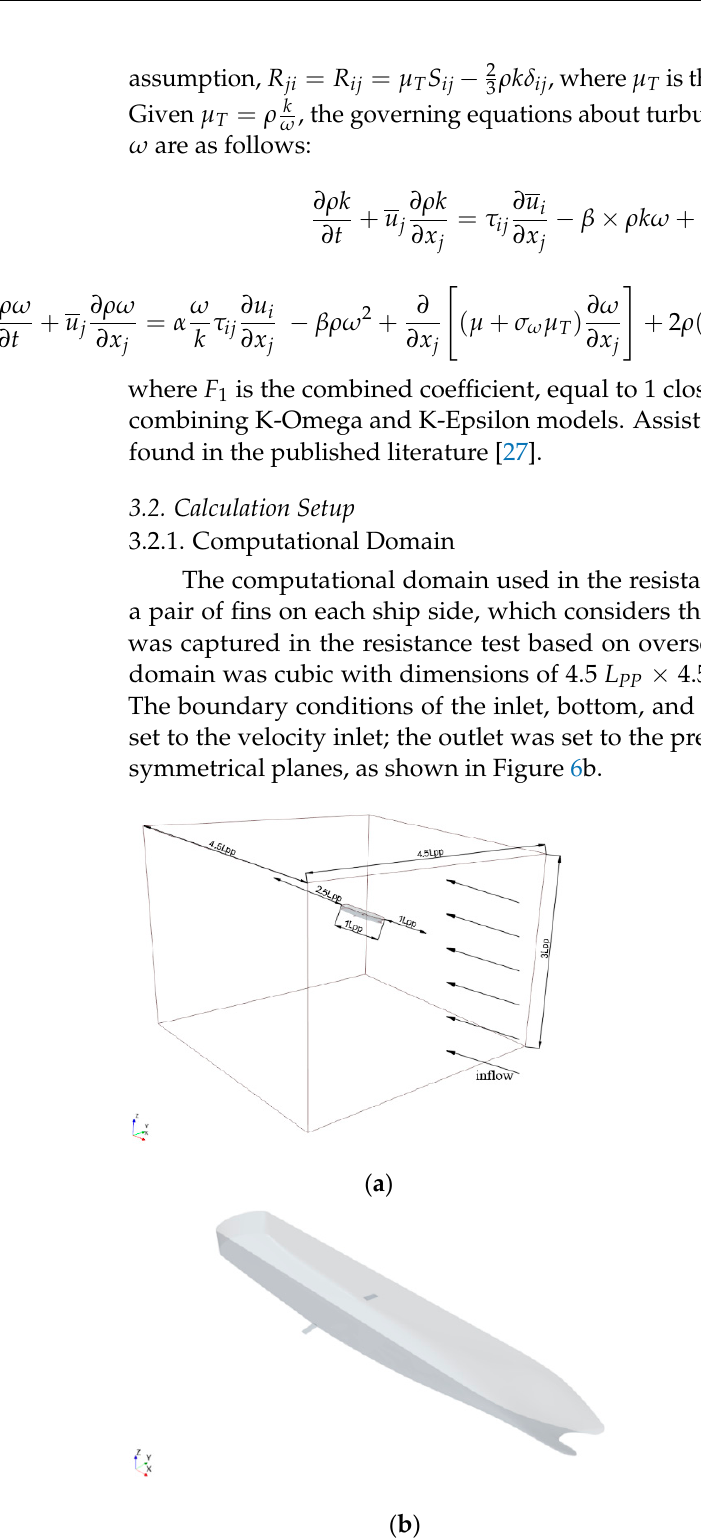
Figure 6. Computation setup. ( a ) Computational domain including the hull model. ( b ) Geometry model of the hull.